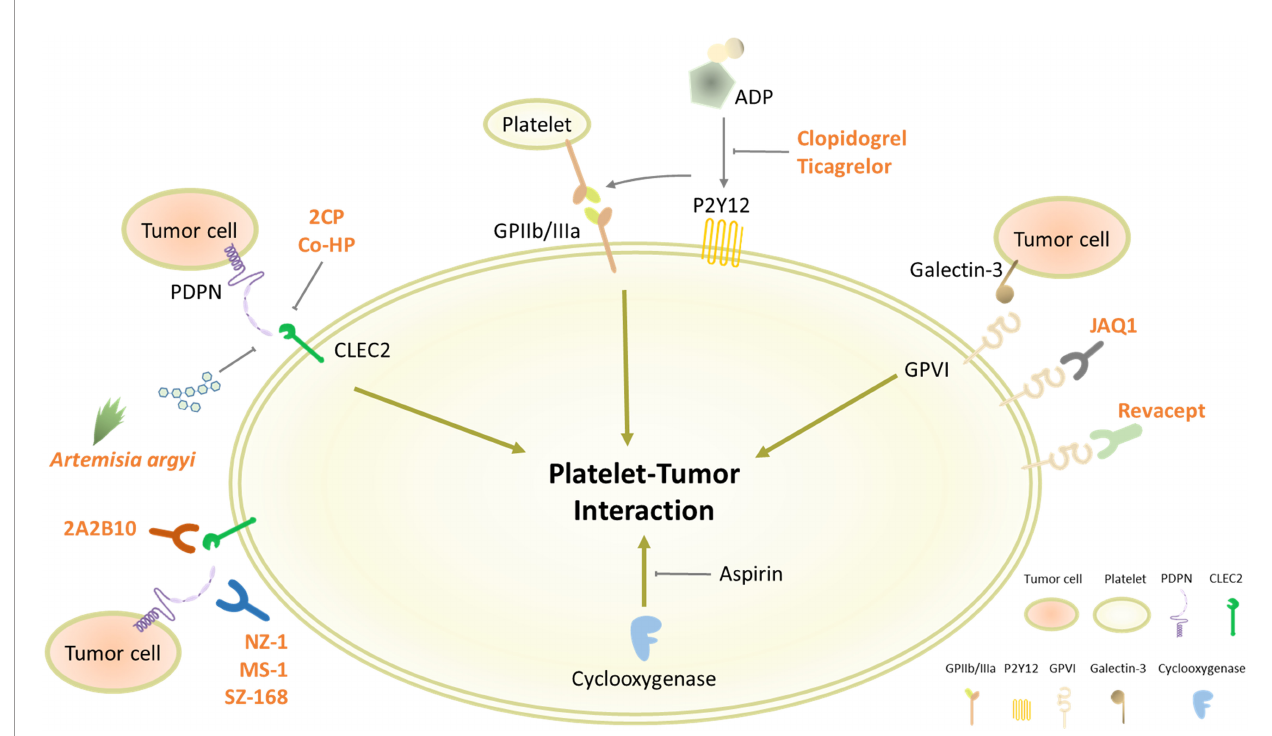
FIGURE 2 | Platelet receptors involved in platelet-tumor interaction. Platelets contain various types of receptors on the cell surface for diverse physiological functions, including cell adhesion and aggregation. Some of the surface molecules, such as CLEC2, P2Y12, and GPVI, can promote the interaction between platelets and cancer cells, which could be plausible targets for blocking TCIPA